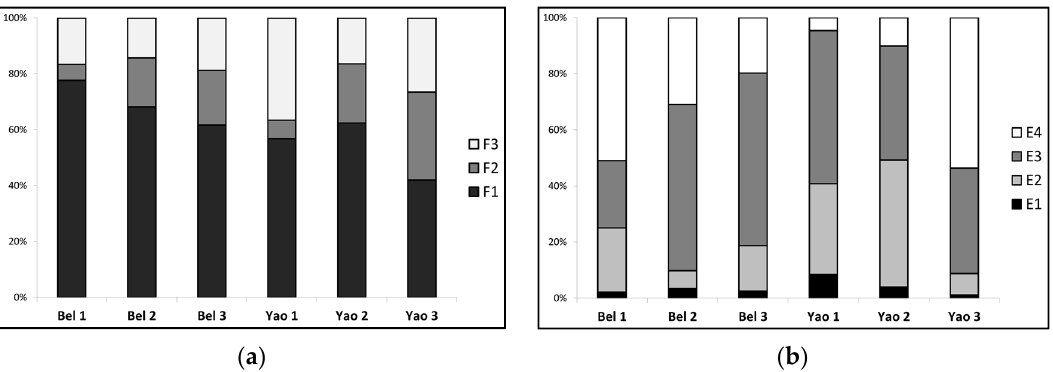
Figure 2. Mercury environmental speciation for the six sites as a percentage of each fraction relative to total mercury. ( a ) Focus on the most mobile fractions of mercury. F1: H 2 O soluble mercury, F2: CaCl 2 exchangeable mercury, F3: EDTA bioavailable mercury. ( b ) Focus on the main extractions of mercury. E1: Extraction of highly mobile mercury, E2: Extraction of mobile and toxic mer cury, E3: Extraction of semi mobile mercury, and E4: Non-mobile mercury.